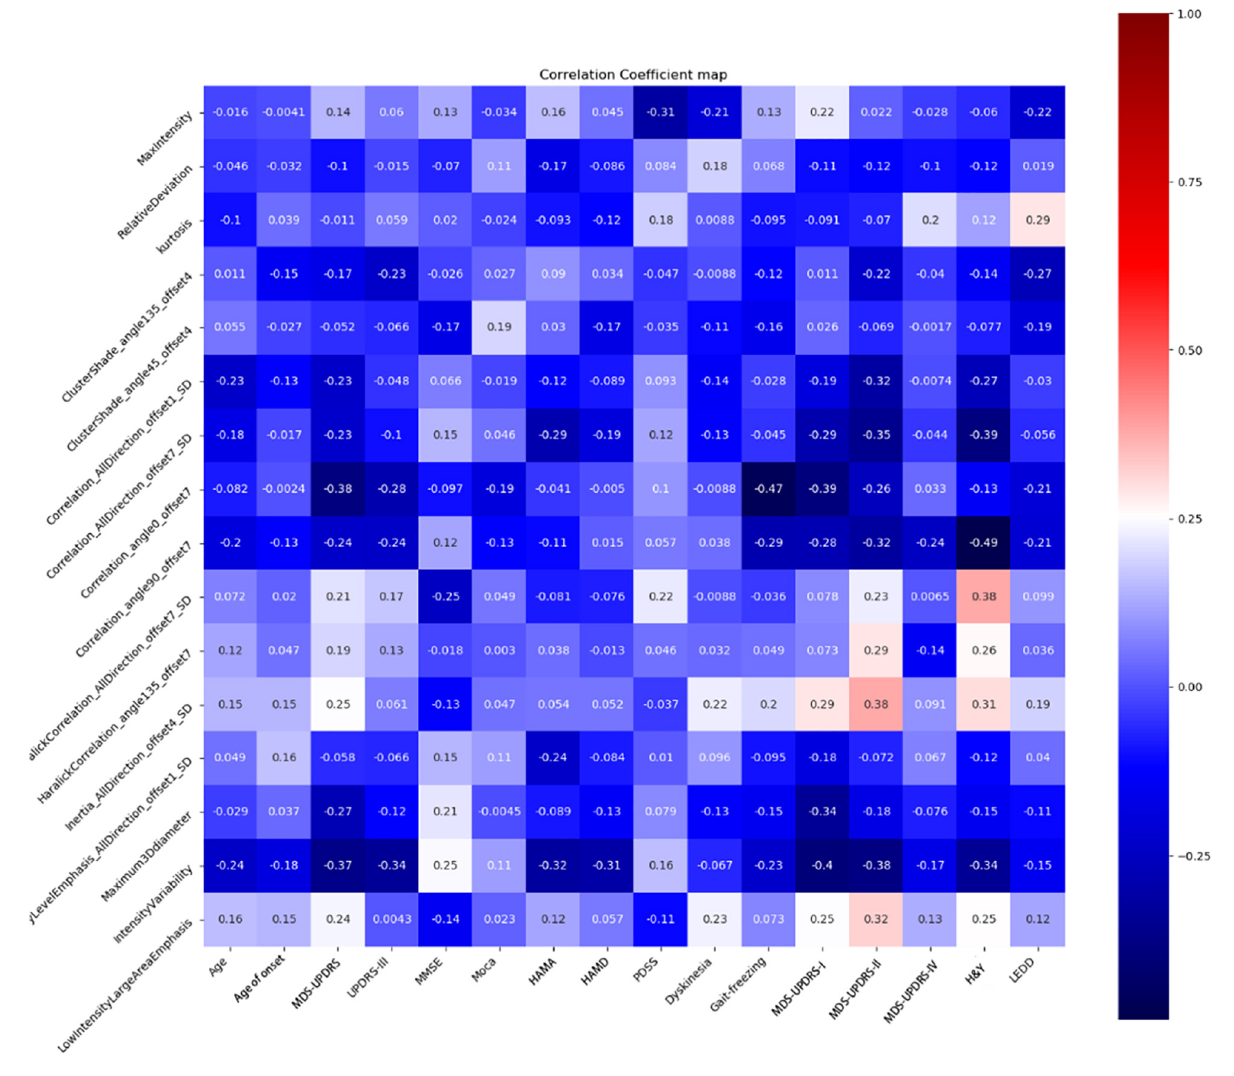
FIGURE 5 | Correlation heatmap of the 16 significant features and clinical